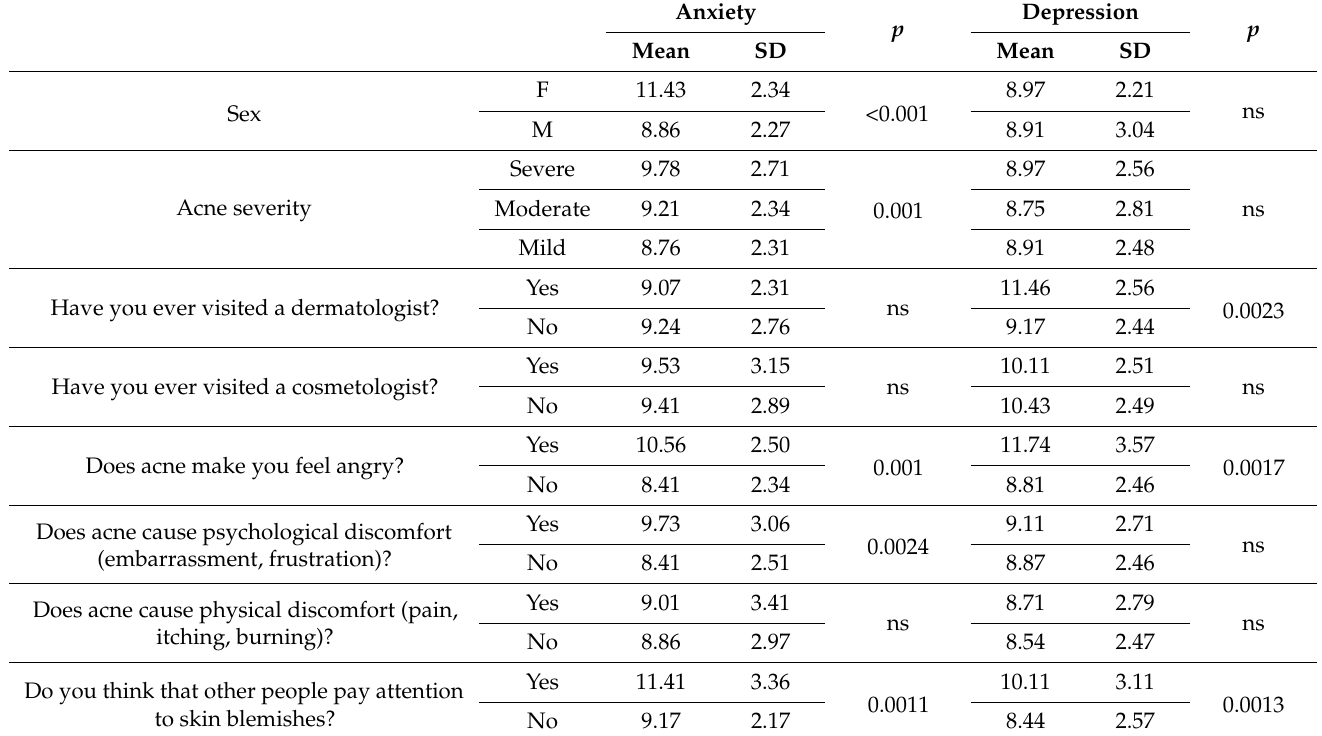
Table 2. Relationships between the respondents’ characteristics, the impact of acne on the respondents’ well-being, and HADS